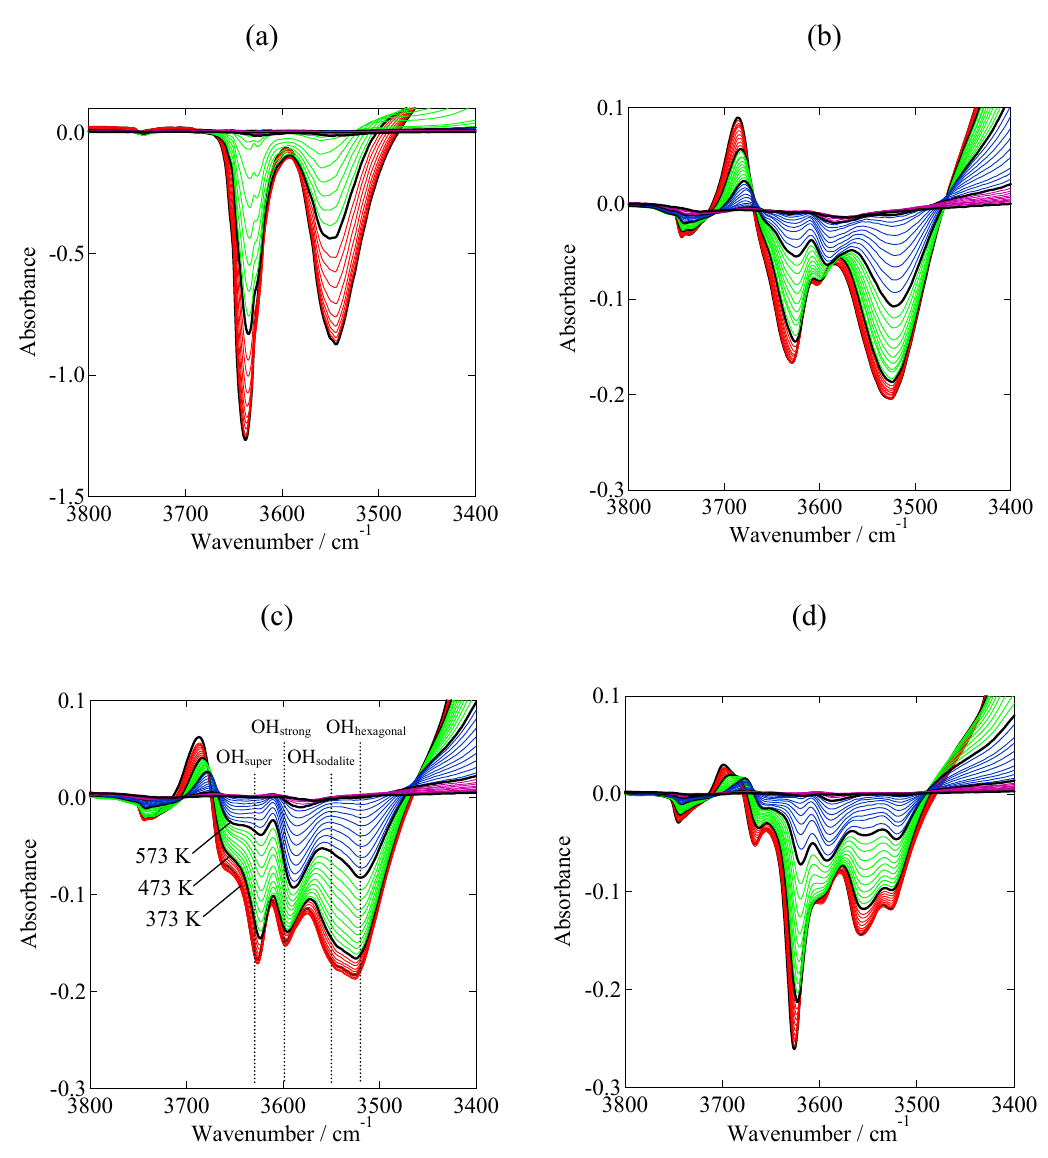
Figure 2. OH region of the difference IR spectra measured on (a) H-Y and (b-d) USY (prepared by steaming with 100% H O for 1 h) with adsorbed ammonia during the 2 elevation of temperature from 373 to 773 K. Spectra were taken every 10 K. Bold lines show the spectra measured at 373, 473, 573 K, 673 K and 773 K. Steaming conditions: (b) 773 K (c) 873 K (d) 973 K.